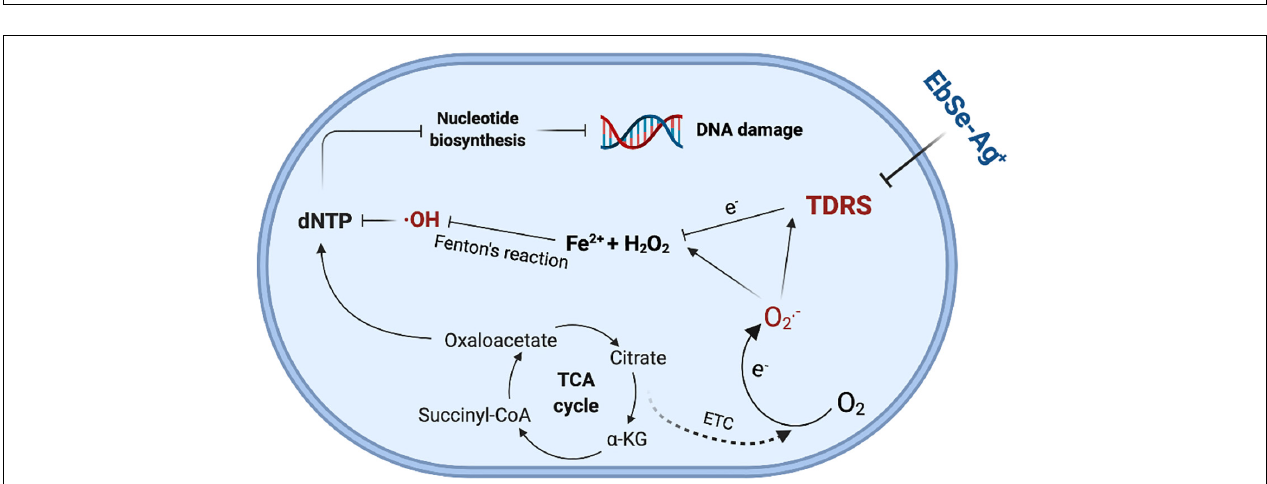
FIGURE 11 | Routine blood analysis of EbSe-Ag + -treated mice. YpIII-illuminous were orally administrated into mice and further treated with EbSe-Ag + . Mice blood was collected 7 days post-infection, and the numbers of (A) WBC and (B) neutrophils, the amounts of (C) ALT, (D) AST, (E) Urea, and (F) creatine were detected.